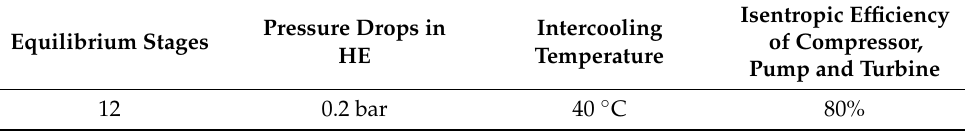
Table 5. Key parameters of the Selexol process